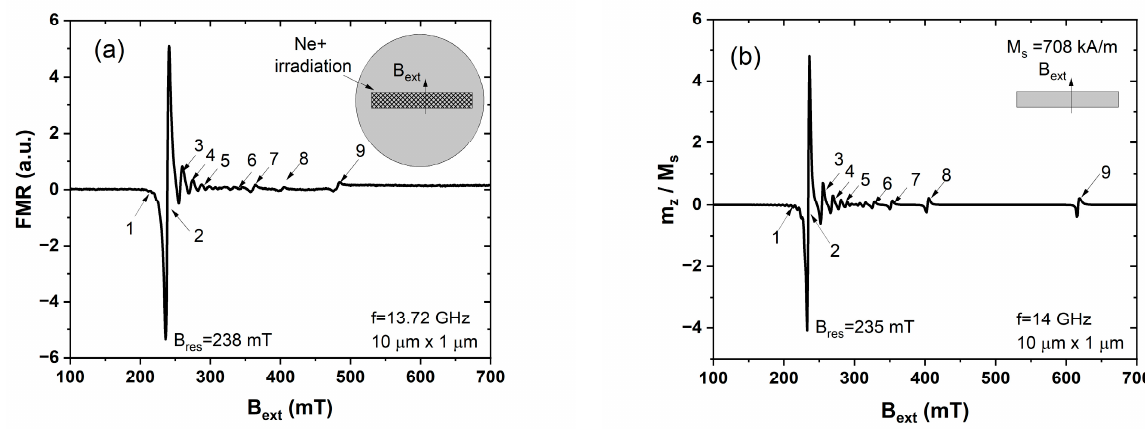
Figure 3. ( a ) Microresonator FMR experiment on an embedded Fe 60 Al 40 strip with the size of 10 × 1 × 0.032 µ m (irradiated with Ne + with E = 25 keV) performed at 13.72 GHz ( b ) mumax3 simulation of a free-standing Fe 60 Al 40 strip at 14 GHz. FMR signals are labelled from 1 to 9. Table 1. Comparison of the resonance field values from experiment and simulation. Except for mode (8), the difference between measurement and simulation is larger for modes more confined to the edge region of the sample (i.e., for modes (6), (7), and (9)). B res ,